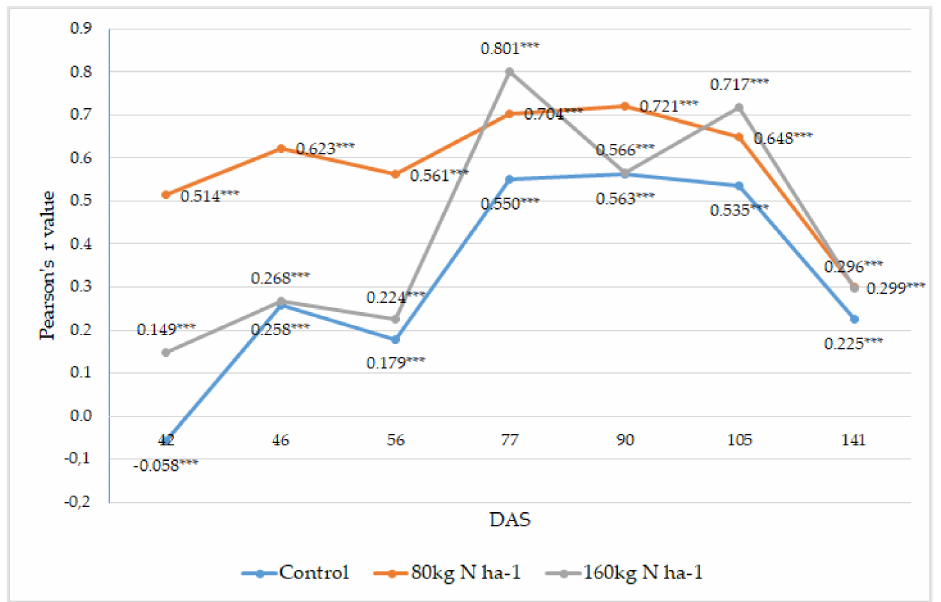
Figure 13. Pearson correlation coefficient (r) dynamics among NDVI UAV and yield t ha − 1 as a result of N fertilization (2021, Debrecen). Note: ***. Correlation is significant at the 0.001